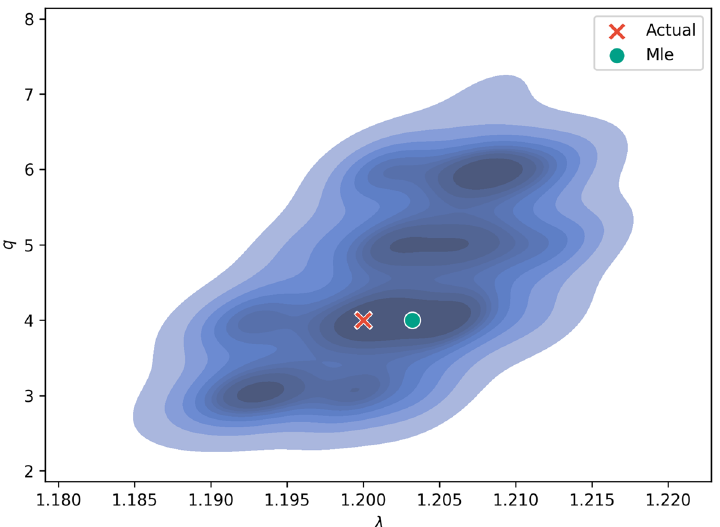
Figure 8. Results of ABC-PMC for the Zipf–Mandelbrot law with data generated with known exponent (cid:31) = 1.2 and q = 4 (red cross) with N = 100,000 words. The likelihood function (darker blue regions have higher likelihood) was approximated using a kernel density estimate. The mode of the KDE gives the maximum likelihood estimate (green circle). The estimator correctly identifies q and is close to the correct exponent (cid:31) .